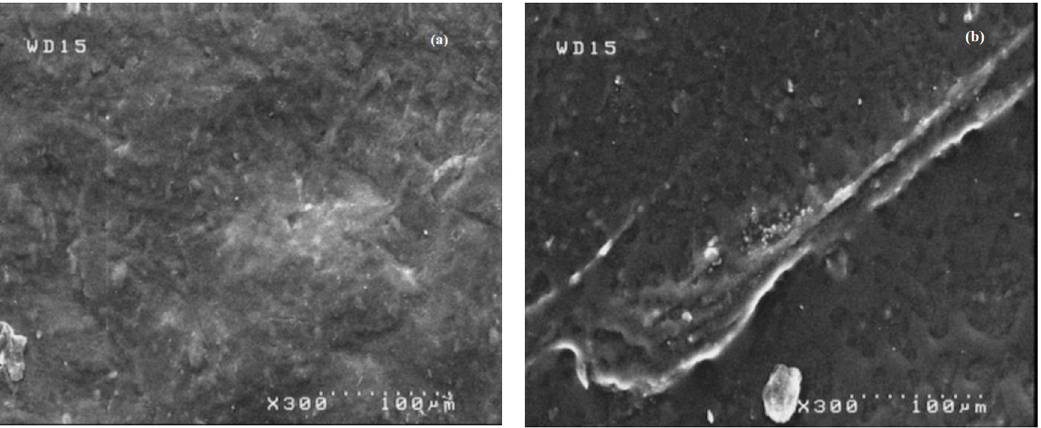
Figure 10. The surface images of ( a ) neat PLA, and ( b ) PLA impregnated at the optimum